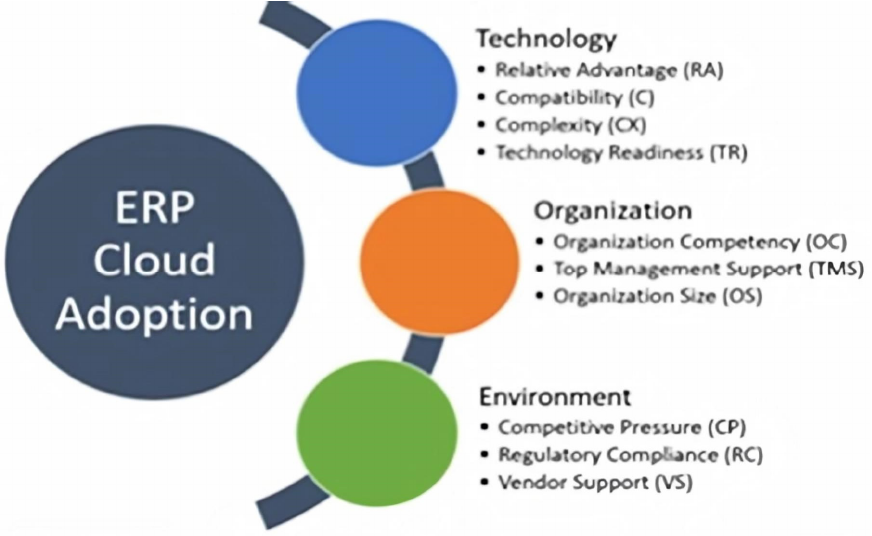
Figure 6. Research model factors.